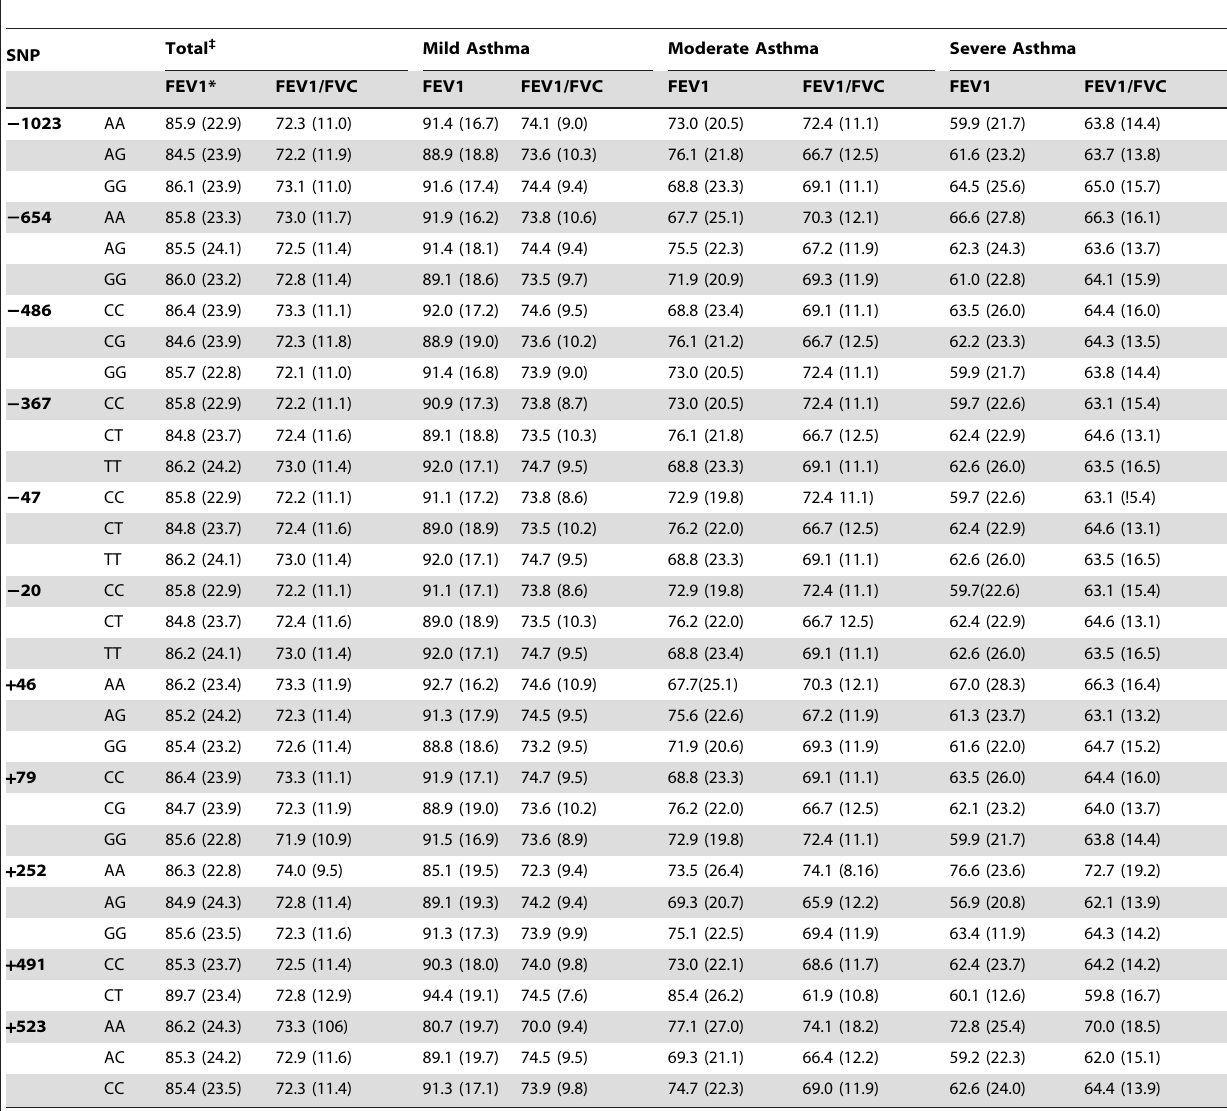
*values indicate % predicted. ` Lung function results only available for the LIWA cohort